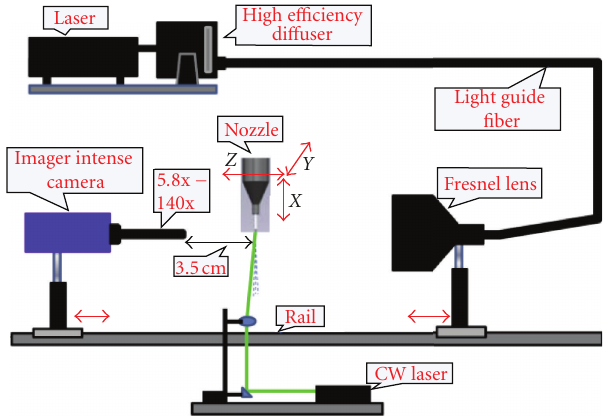
Figure 13: Schematic of shadowgraph system for the measurement of aerosol particles, from Mahmud et al. [86], Copyright 2010 ASME. Reprinted with